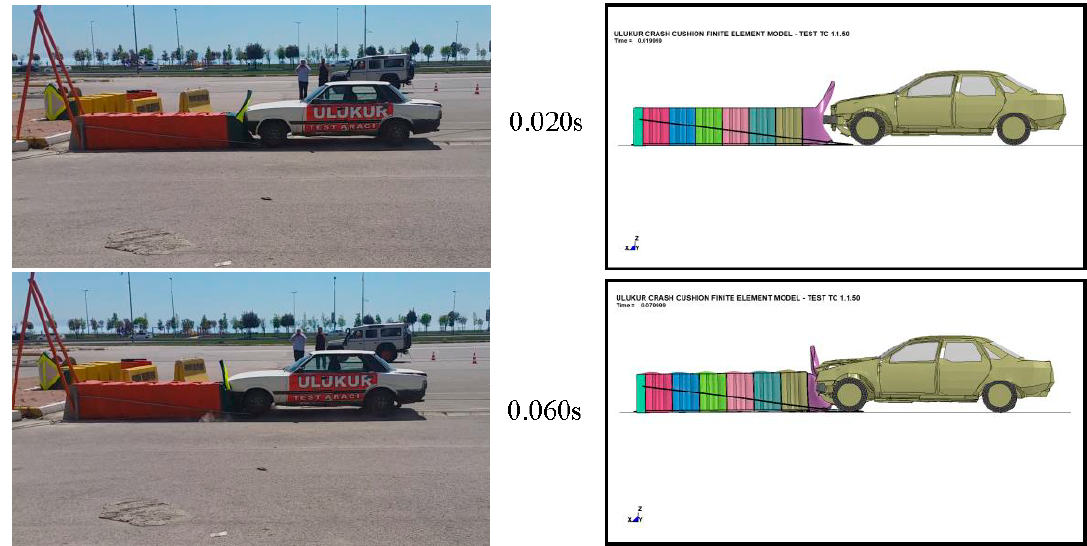
Figure 6. The 900 kg car positioned in front of UCC barrier before TC 1.1.50.